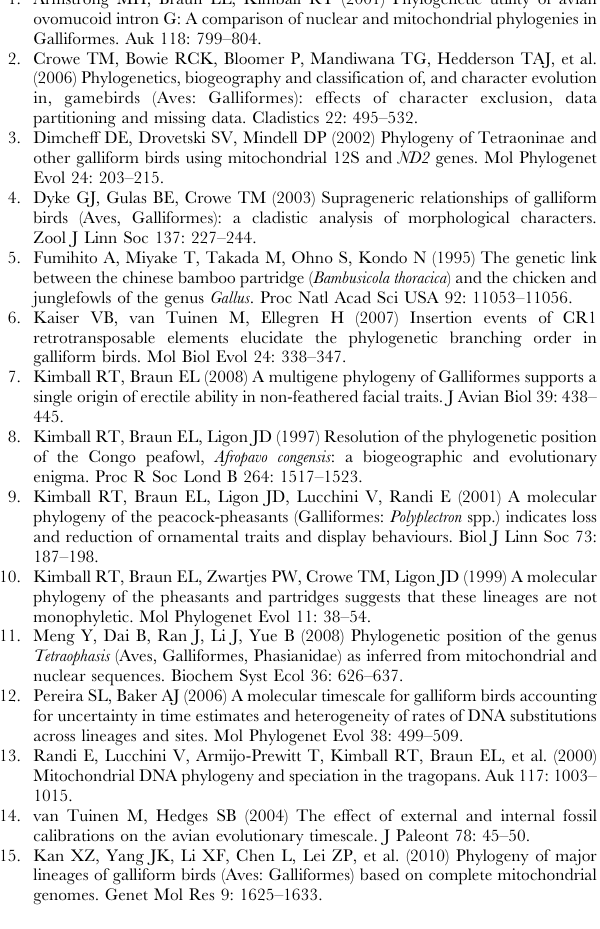
Figure S5 Bayesian phylogenetic tree based on the combined dataset of 13 mt protein-coding genes and seven nuclear segments. File S1 This file contains Table S1 and Table S2. Table S1, Source of sequence data for mitochondrial genomes and nuclear segments. Table S2, List of primers used in this study of the